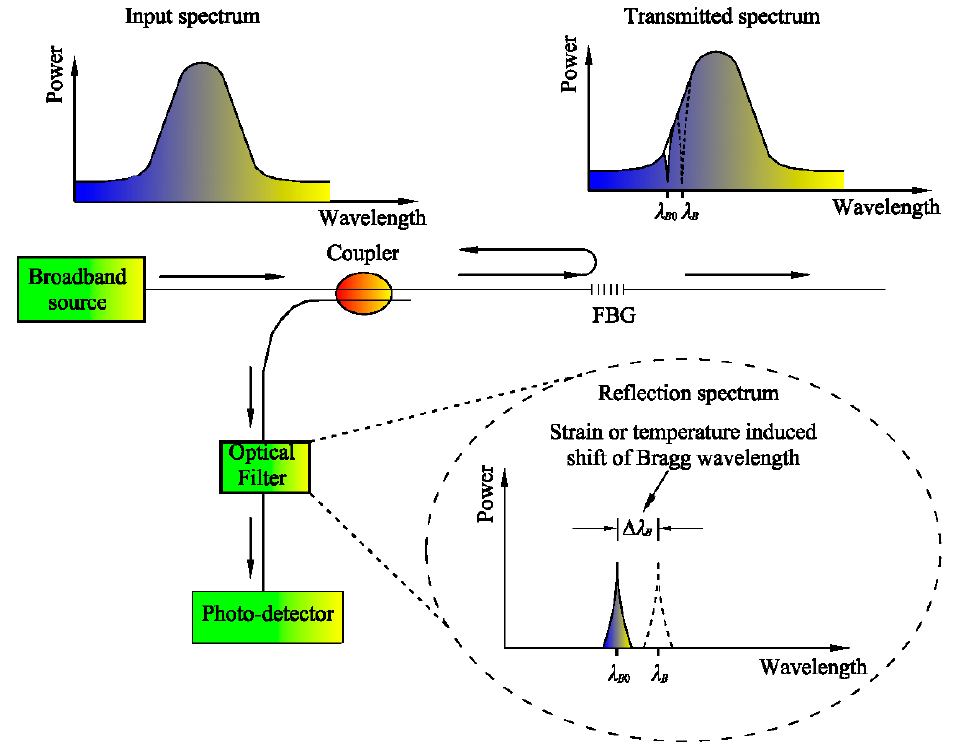
Figure 1. Generic concept of the FBG sensor.